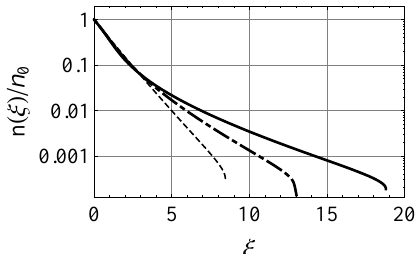
Figure 5. Numerical results for the electron fluid velocity with al- titude varying sound speeds. We use the sound speed C s0 at z > 0 for normalisation. The heavy line has A C = 2; the dashed heavy line A C = 1. A thin dashed line gives the Lambert W solution with constant C s for reference, i.e. A C = 0. In all cases we have u 0 = 0 . 01 C s0 .